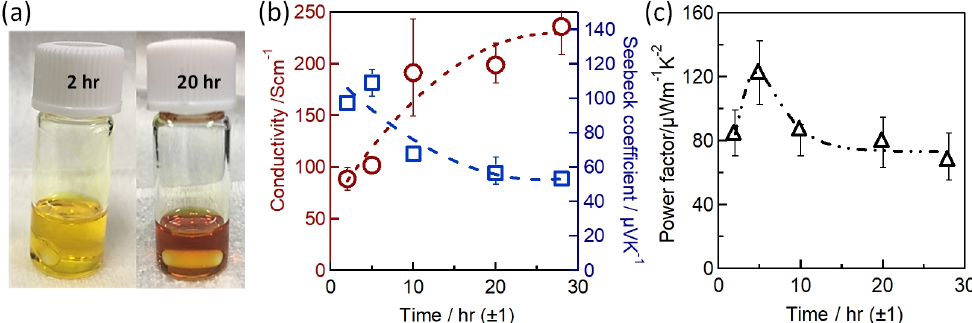
Figure 29. ( a ) CsSnI 3 precursor color change under DMSO co − solvent following 20 h of stirring at 70 ℃ hotplates. The vial was stirred inside a glove box (O 2 and H 2 O < 0.5 ppm), ( b ) Variation in Electrical conductivity and Seebeck coefficient with the precursor stirring time, ( c ) Power factor variation with stirring time effect. Reproduced with permission [38]. Copyright 2019, Springer Nature.